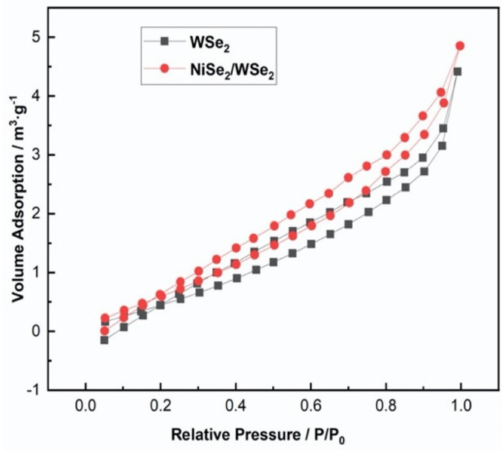
Figure 6. Adsorption–desorption curve of N 2 .